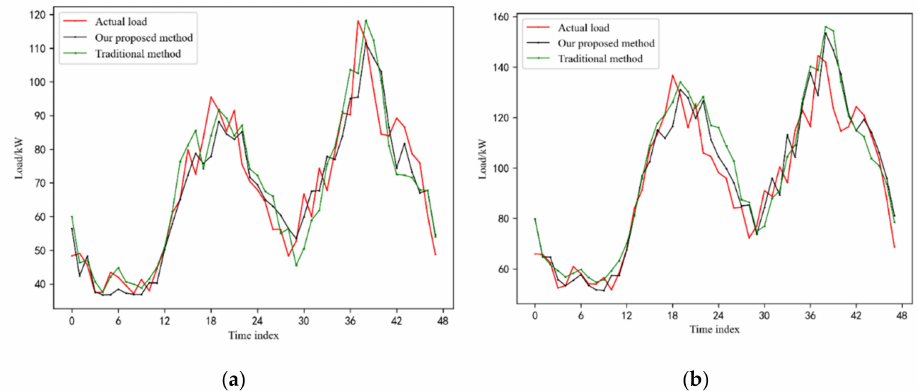
Figure 9. The detailed forecasting results at 48 points on 31 March ( a ) 150 households; ( b ) 200 households.